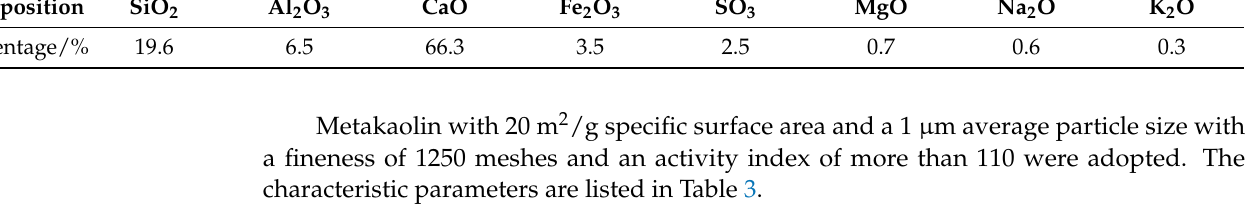
Table 2. The characteristic parameters of cement. Table 3. The characteristic parameters of